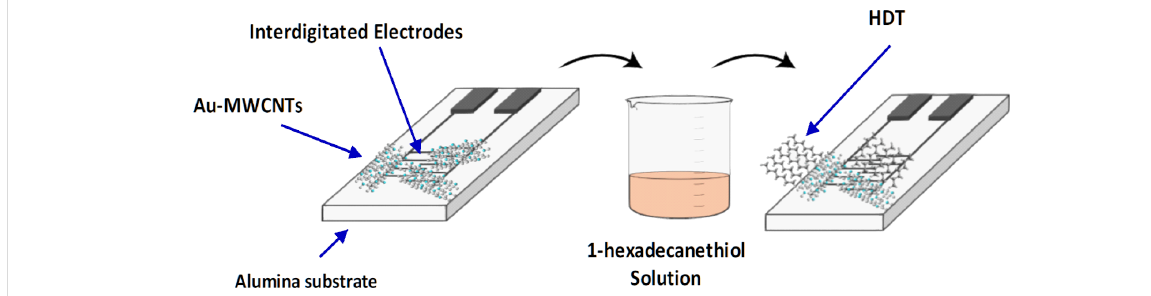
Figure 1: Synoptic structure of the sensor before and after the HDT deposition.